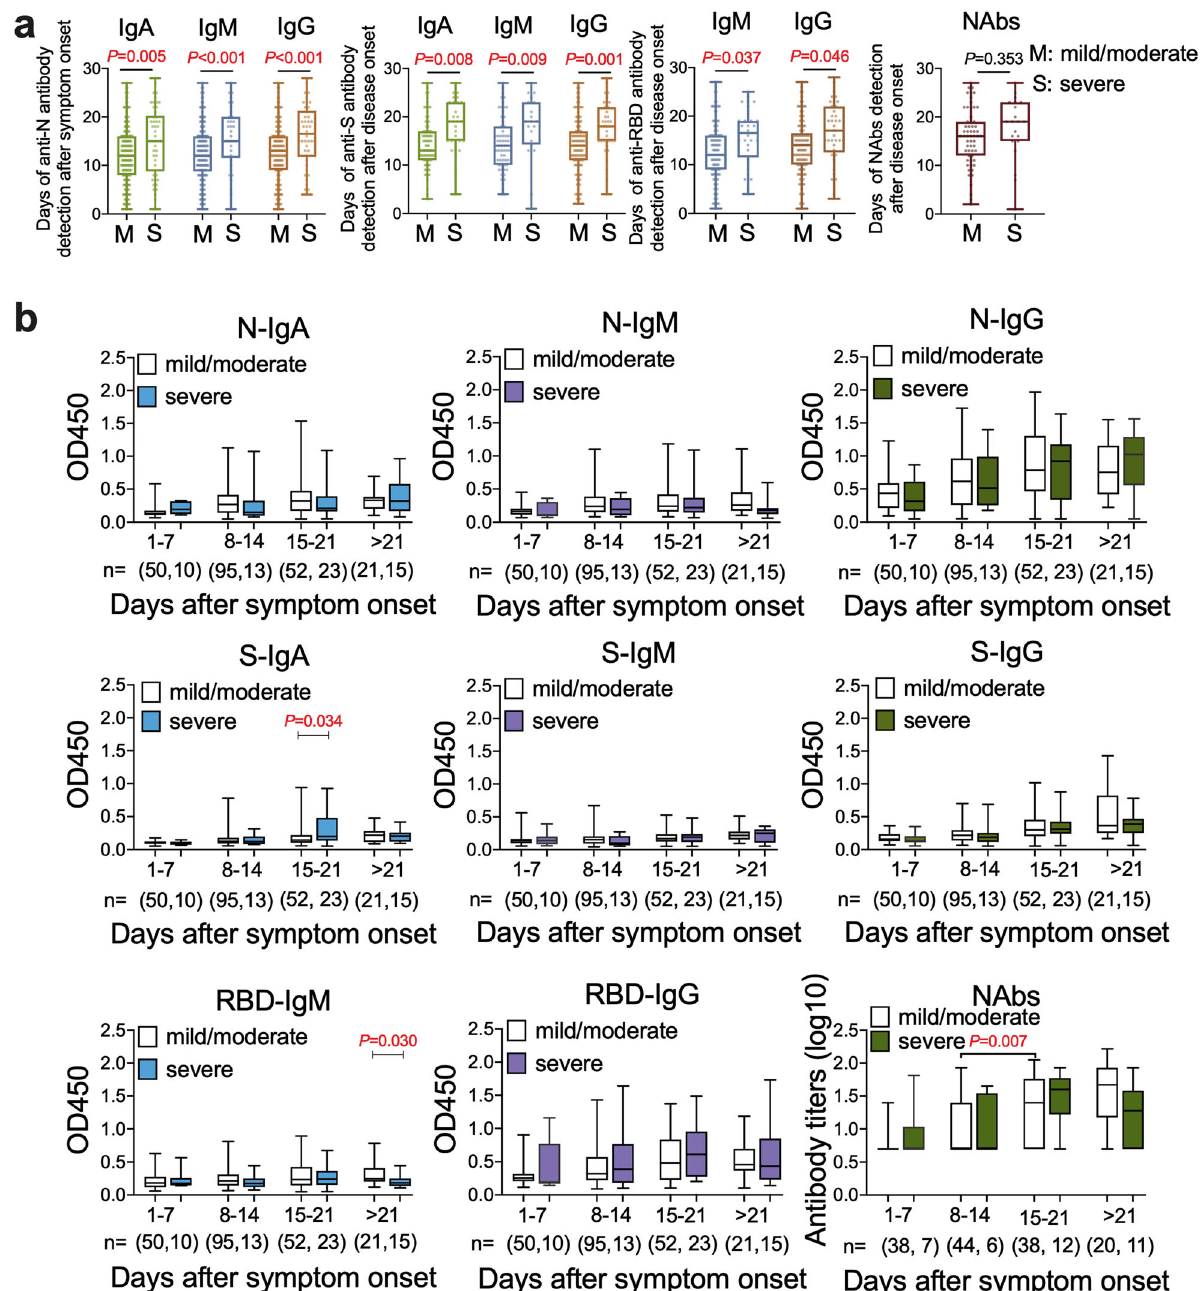
Fig. 2 The pro fi les of antibodies in mild/moderate and severe COVID-19 patients. a The appearance time of IgA, IgM, IgG and total neutralizing antibodies (NAbs) between mild/moderate and severe cases. The onset time of anti-SARS-CoV-2 antibodies against nucleocapsid (N), and spike (S) proteins, anti-receptor binding domain (RBD) IgM and IgG, and NAbs against SARS-CoV-2 in mild/moderate (M) and severe (S) patients is indicated. b The optical density (OD) value of IgA, IgM and IgG antibodies against SARS-CoV-2-N, S and RBD are shown while the NAbs titers showed by geometric mean titers over the time course of the disease. The sample number of mild/moderate and severe were provided. The median and quartiles were represented in the boxplots and the bars represent the maximum and minimum